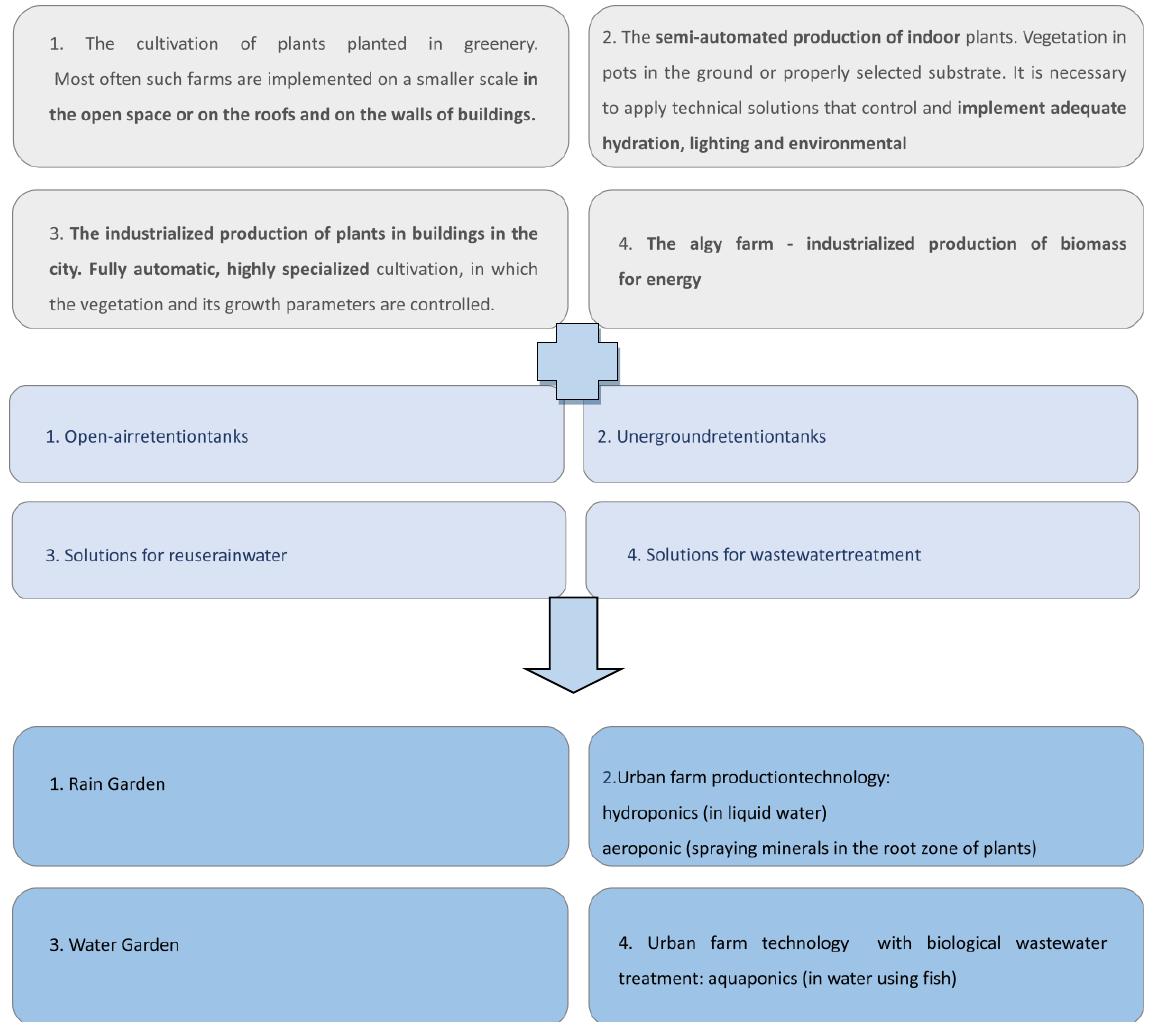
7 Figure 2. A schematic research process—integrating the described typologies of urban farms, water retention, and